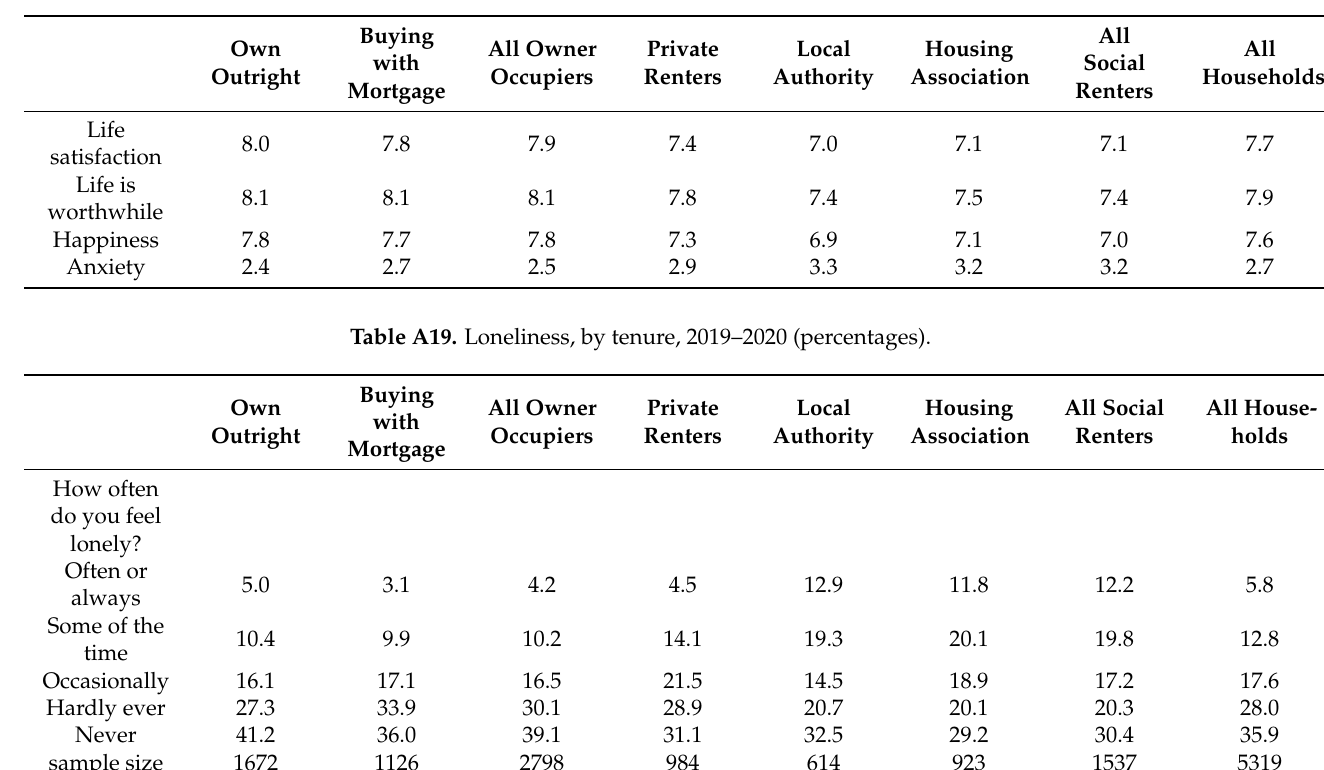
Table A18. Well-being, by tenure, 2019–2020.